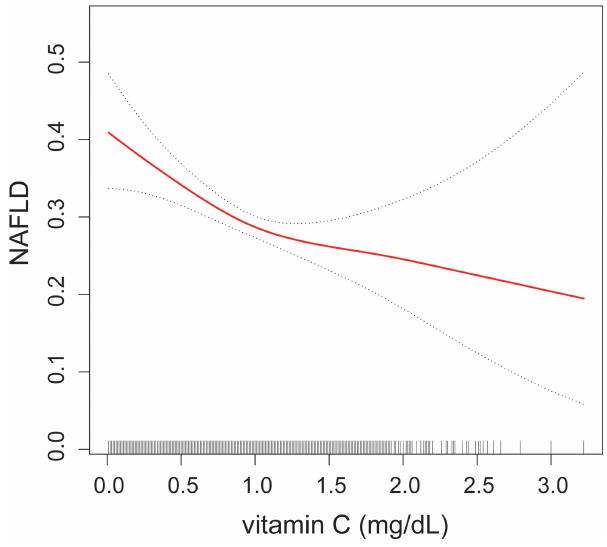
Figure 2. The relationship between serum vitamin C and the risk of NAFLD. A non-linear relationship between serum vitamin C and the risk of NAFLD was observed after adjusting for age, gender, race, education level, family PIR, body mass index, hypertension, diabetes, total cholesterol, triglyceride, smoke state, vitamin A, vitamin E. NAFLD, non-alcoholic fatty liver disease; PIR, poverty-to-income ratio.